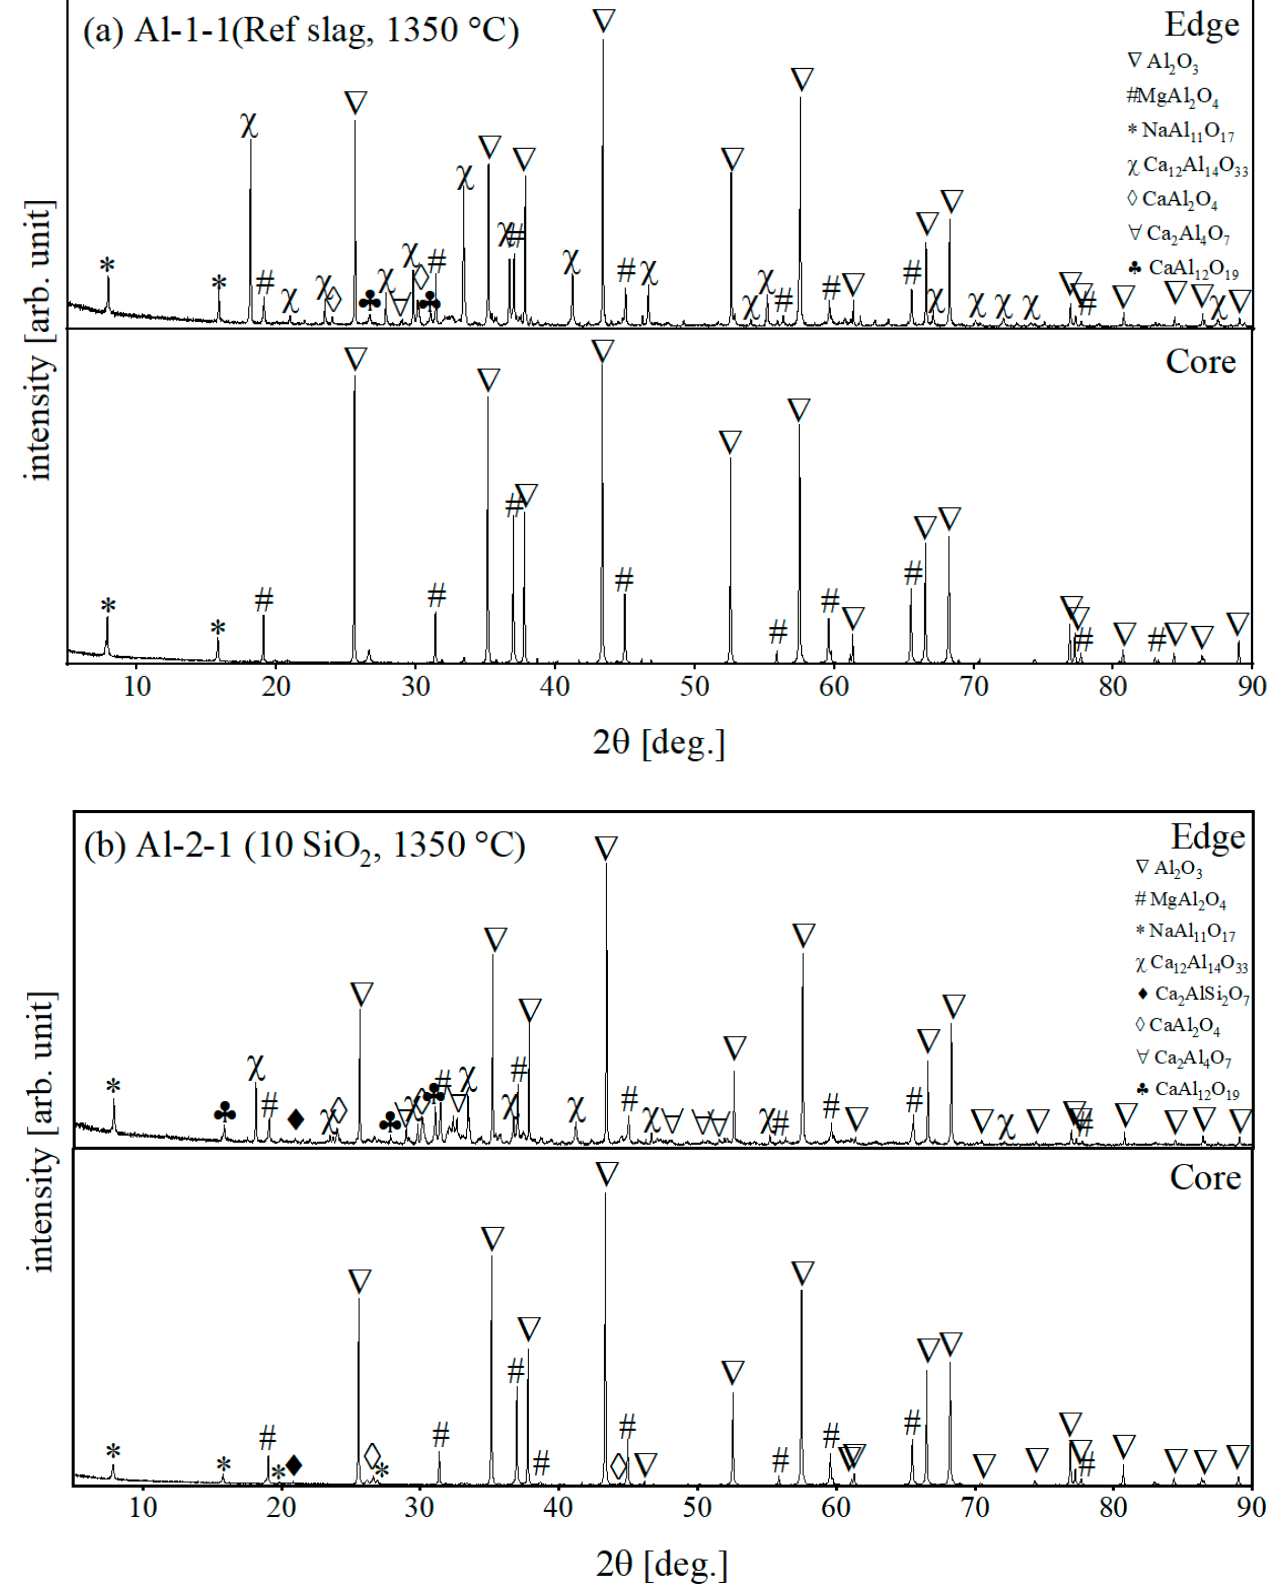
Figure 10. XRD patterns of ( a ) Al-1-1 (slag R) and ( b ) Al-2-1 samples (slag S), for 1350 °C.